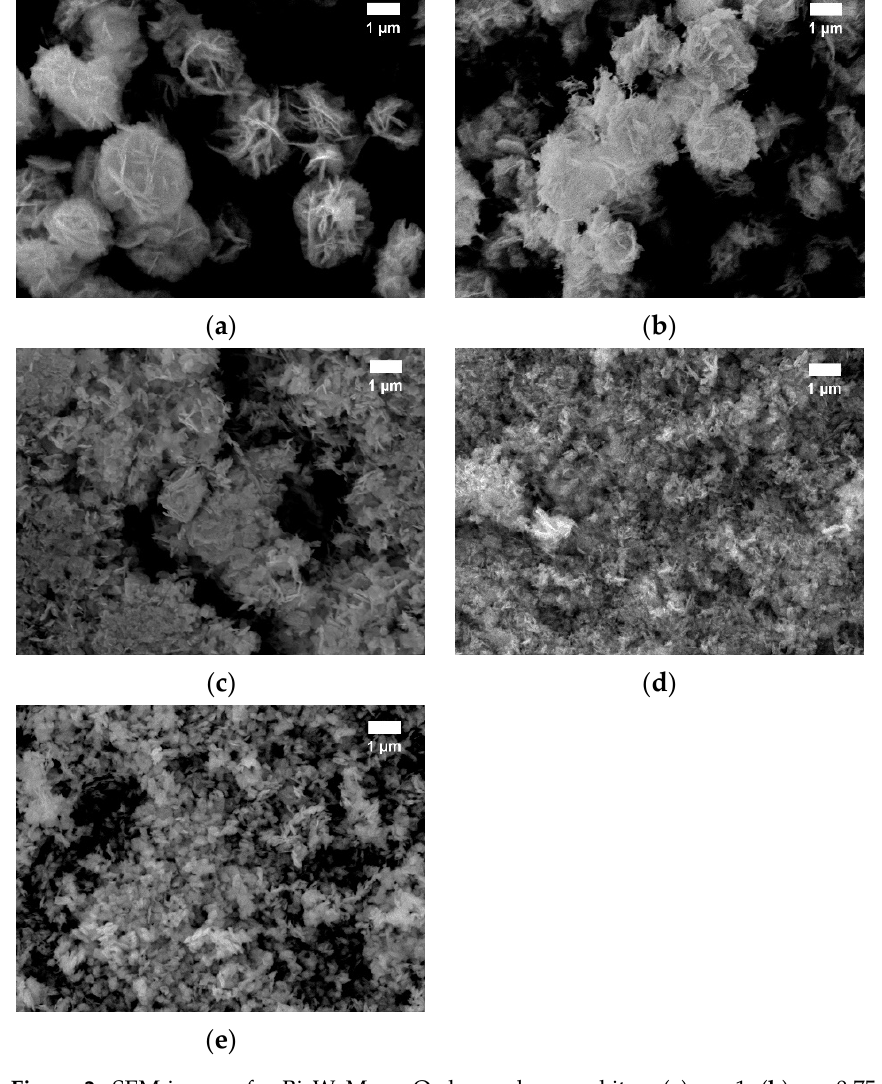
Figure 2. SEM images for Bi 2 W x Mo 1 − x O 6 layered perovskites: ( a ) x = 1; ( b ) x = 0.75; ( c ) x = 0.5; ( d ) x = 0.25; ( e ) x = 0. The study of the elemental composition of the obtained samples also confirmed the formation of solid solutions with a given composition within the sensitivity of the method